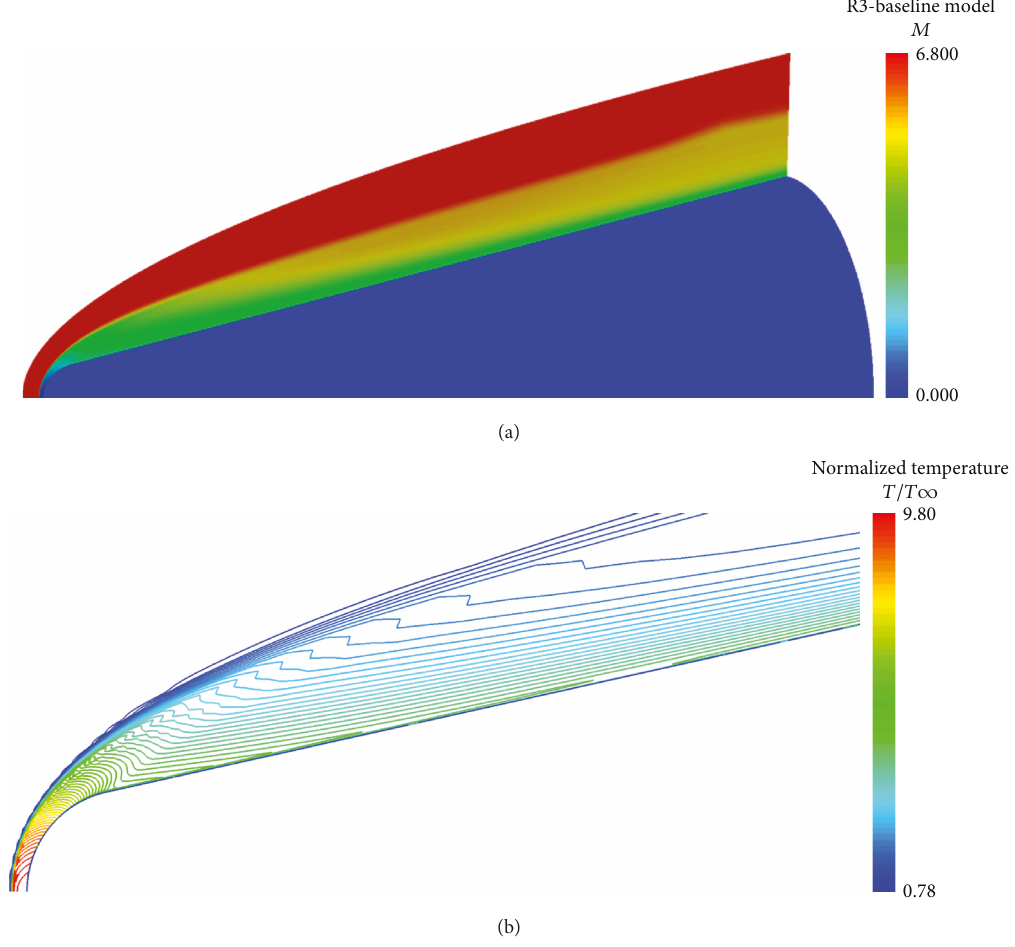
Figure 8: (a) Model R3, Mach number distribution, Re = 4 4 × 10 6 , α = 0 0 ° , M = 6 8 . (b) Model R3, normalized temperature, Re = 4 4 × 10 6 , α = 0 0 ° , M = 6 8 .